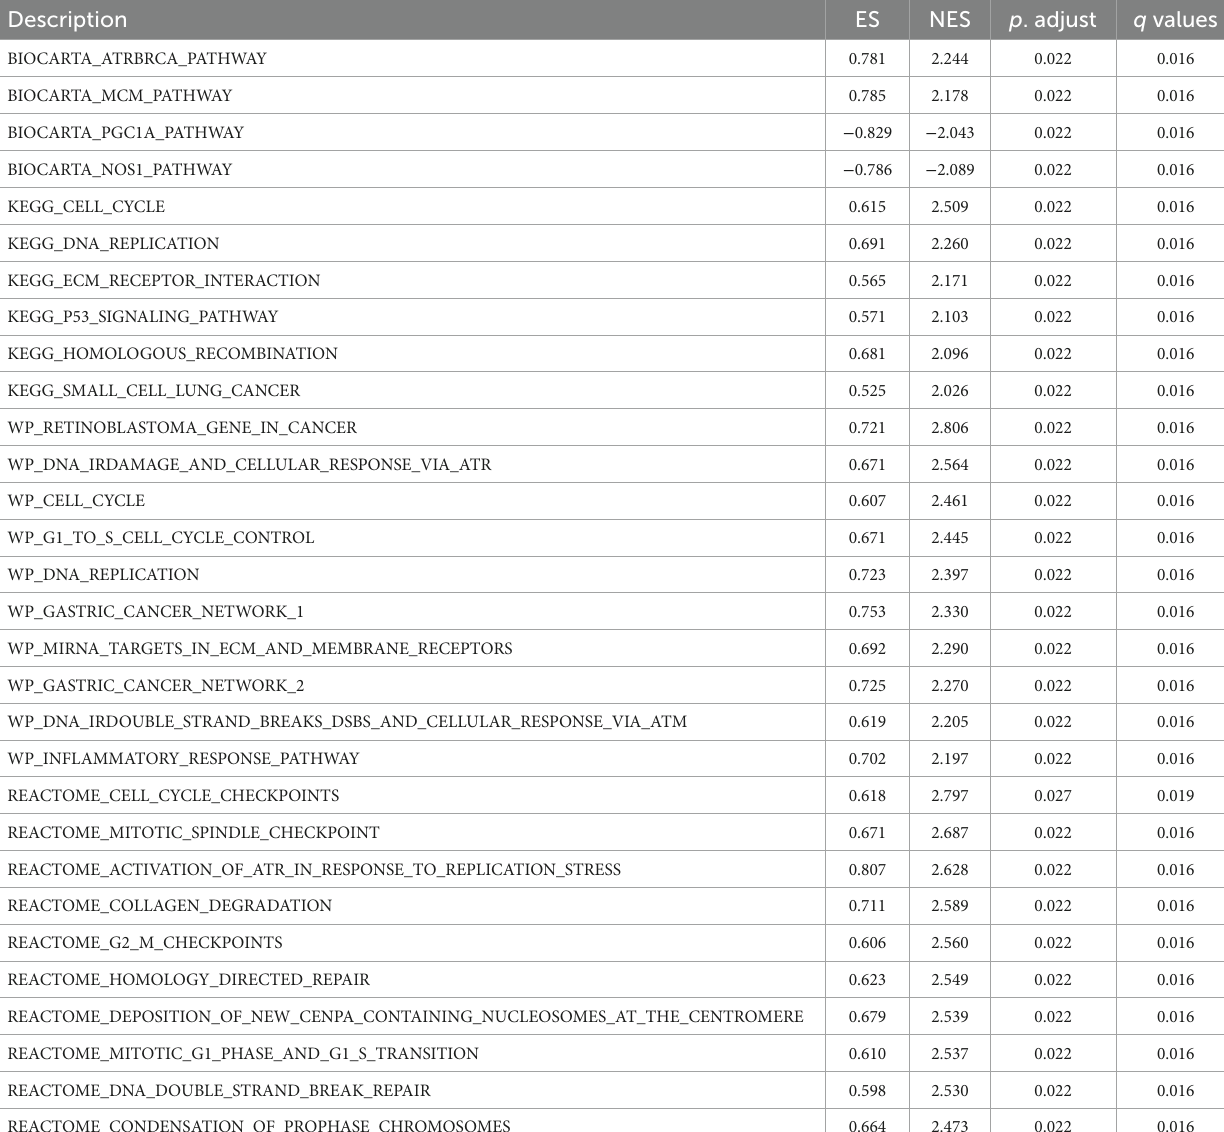
TABLE 5 GSEA significant enrichment results for TMEM131L expression in TCGA-GCBLGG dataset.